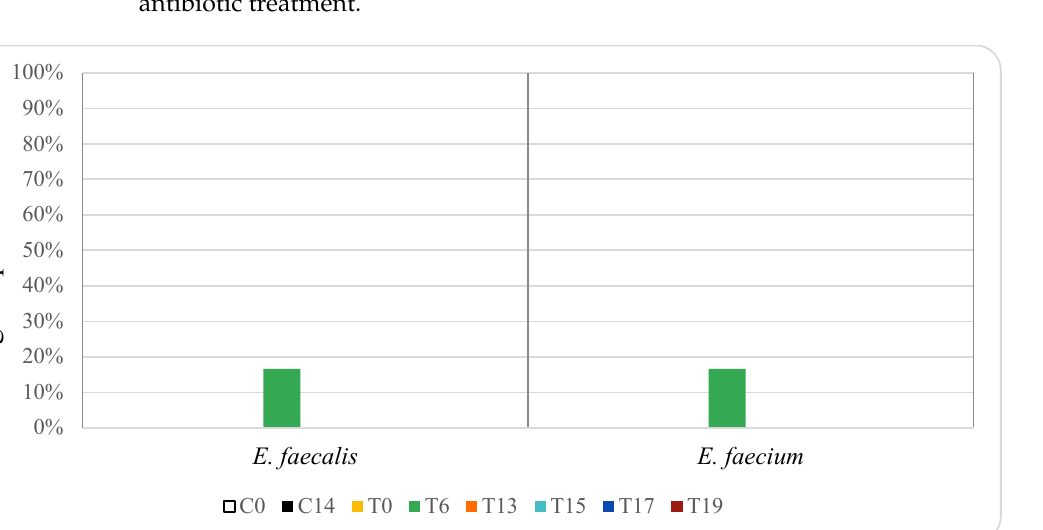
Figure 4. Effect of enrofloxacin treatment on vancomycin-resistant enterococci in pig genital sam- ples. For group descriptions C0, C14, E0, E3, E4, E5, E6, E7: see Table 1. Figures 5 and 6 show the percentage of animals in which ESBL-producing E. coli and K. pneumoniae isolates were found in rectal samples from pigs treated with oxytetracycline and enrofloxacin, respectively. ESBL-producing E. coli was not detected in rectal samples taken from animals treated with oxytetracycline on days 0 and 19. However, on days 6 to 17, it was isolated among 17–20% of the animals treated with oxytetracycline (1 piglet). In animals treated with enrofloxacin, ESBL producing E. coli was detected in 25% of the ani- mals on day 0 (three piglets), on days 3 and 4 was observed in 17% of the animals (1 piglet) and on days 5–7 was among 33 and 50% (between 2 and 3 piglets). ESBL-producing E. coli was not detected in rectal samples taken from control animals, not receiving any antimi- crobial treatment. Significant differences ( p < 0.05) in the prevalence of ESBL-producing E. coli were found in rectal samples among the three groups of animals studied, and thus depended on antibiotic treatment. ESBL-producing K. pneumoniae was detected in 17–20% of the rectal samples taken from animals treated with oxytetracycline (between one and two piglets), except on day 13 (0%). In animals treated with enrofloxacin, ESBL producing K. pneumoniae was 0% on days 0, 3 and 5, while on days 4, 6 and 7 the percentage was 17% (one piglet). ESBL-